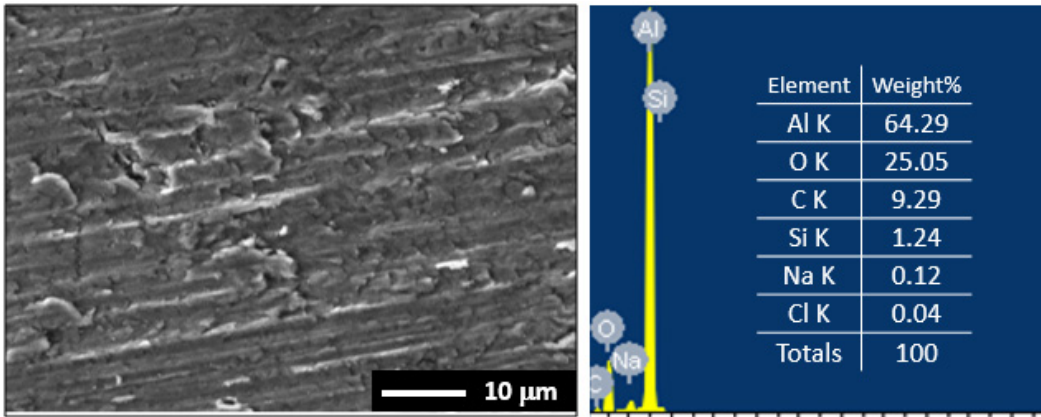
Figure 14. SEM and EDX analyses collected for the second nanocomposite.